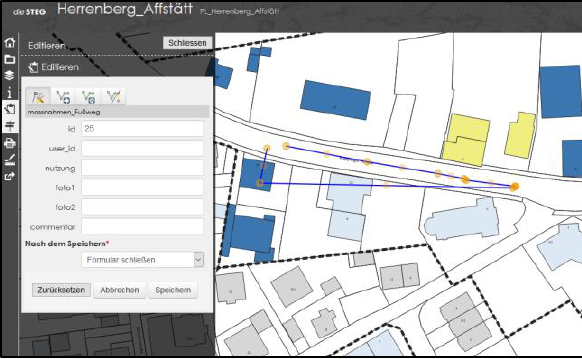
Figure 10 : Creating a new geometry and automatic map updating according to defined symbols in the map